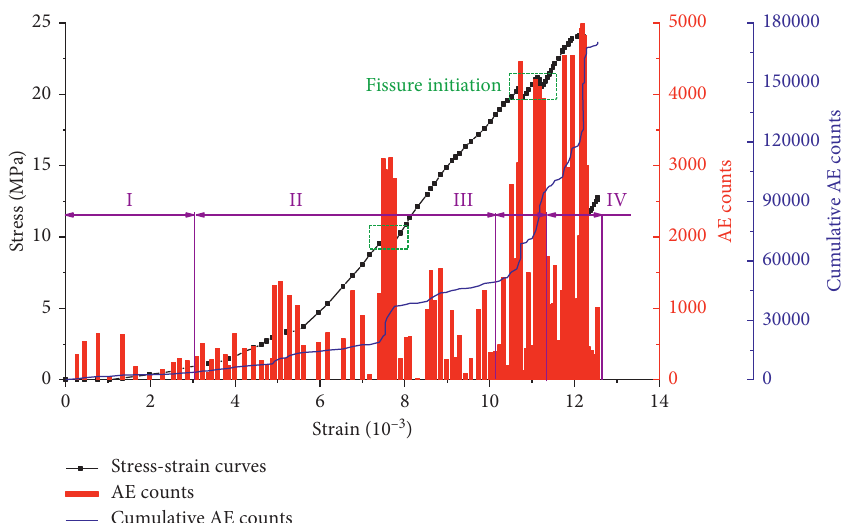
Figure 4: Stress-strain curve and acoustic emission monitoring curve of coal sample after immersion in distilled water.